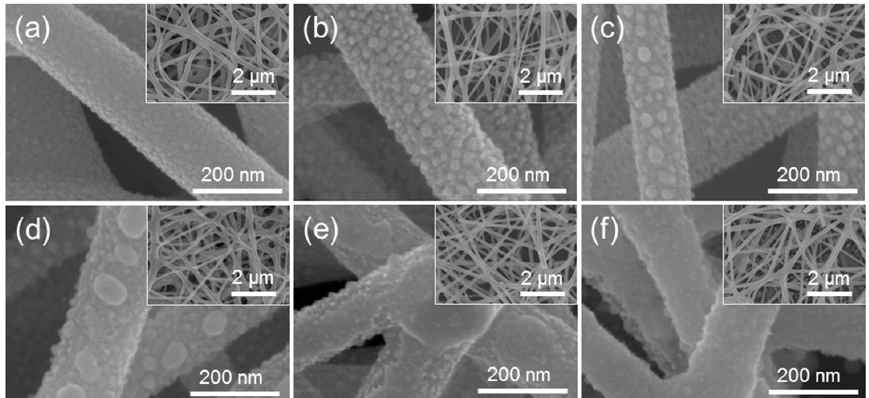
Figure 1. FE-SEM images of ( a ) pure SnO 2 NFs, and SnO 2 NFs functionalized with Pt NPs containing ( b ) 0.2 at.%; ( c ) 0.3 at.%; ( d ) 1.2 at.%; ( e ) 2.0 at.%; and ( f ) 5.4 at.% Pt; Pt films of 3, 5, 10, 15, and 20 nm, respectively were deposited and subsequently heat-treated. The insets are the corresponding low-magnification FE-SEM images of SnO 2 NFs functionalized with NPs.